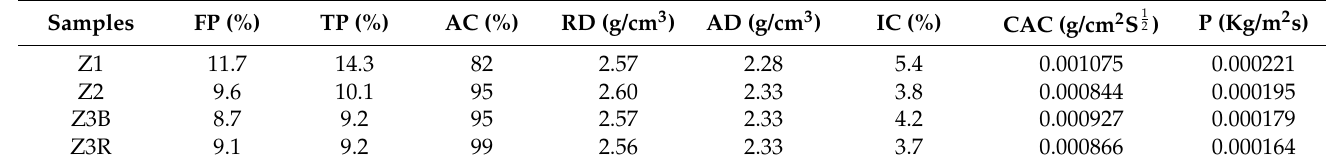
Table 1. Physical characterisation of Zamora building stones by